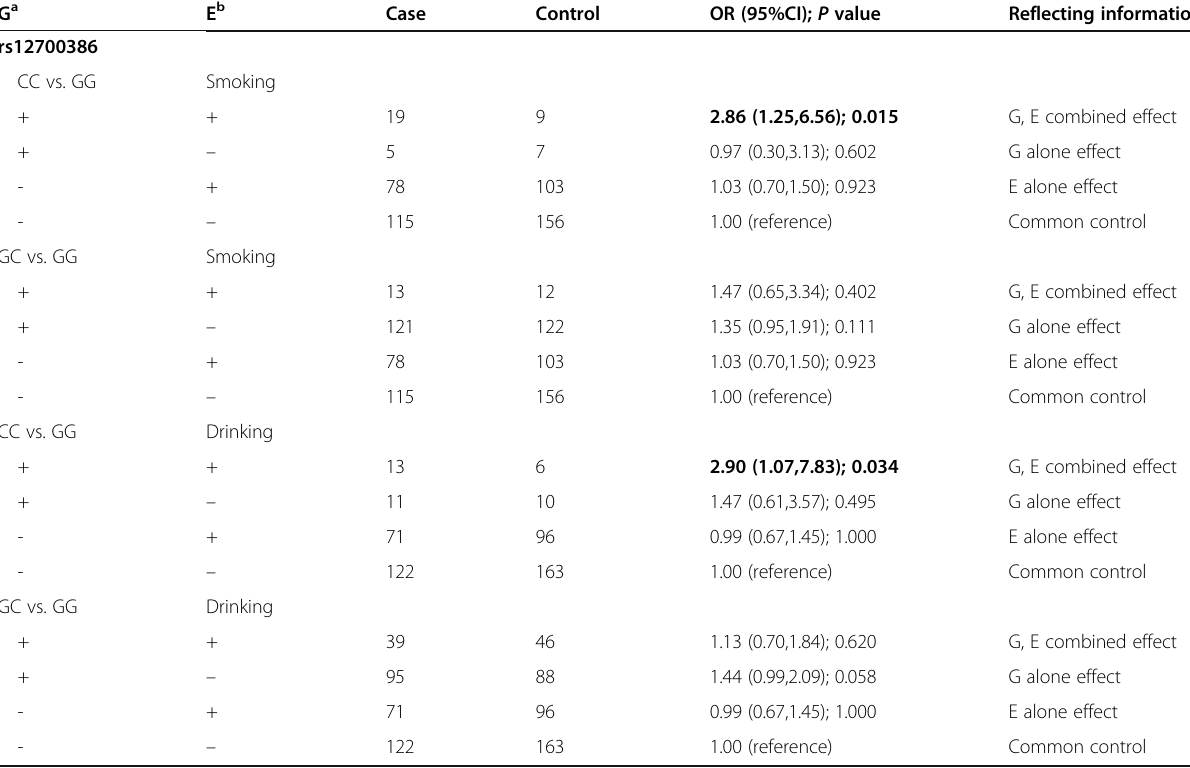
Table 5 Genetic (G) and environmental (E) factors 2*4 fork analysis G a E b Case